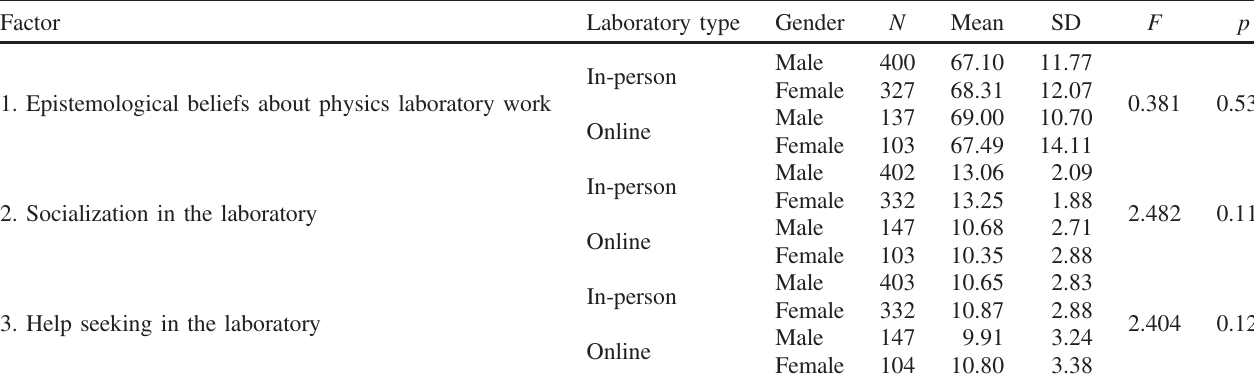
TABLE IV. Statistical tests of interaction effects of laboratory course type and gender.